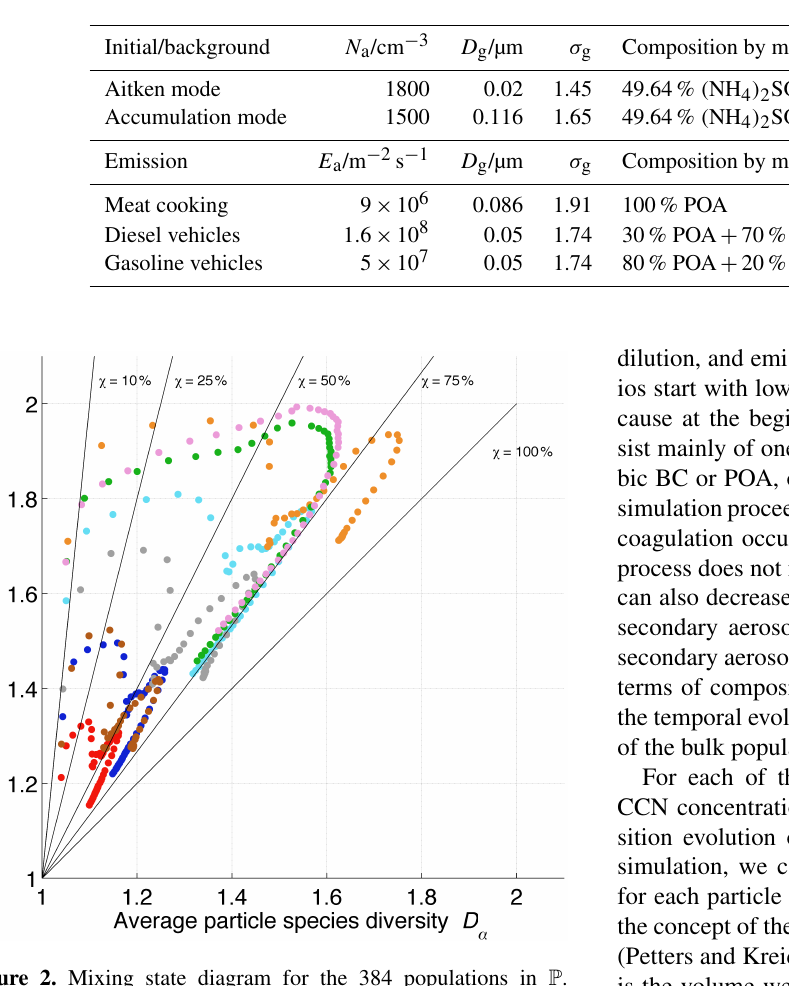
Table 3. Number concentration, N a , of the initial and background aerosol population, and area source strength, E a , of the three types of emission. All aerosol size distributions are assumed to be log-normal and defined by the geometric mean diameter, D g , and the geometric standard deviation, σ g .